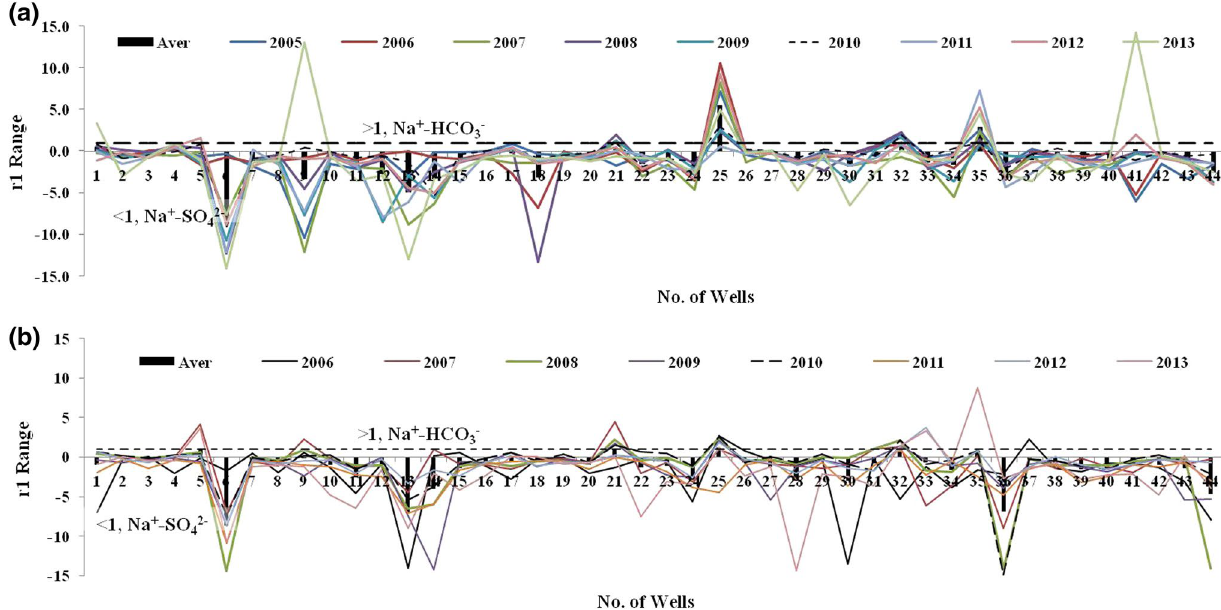
Fig. 14 a Nine-year (2005–2013) temporal representation of r